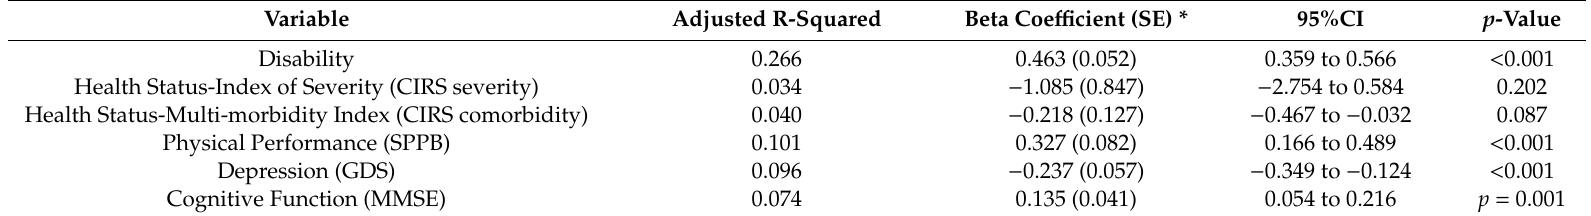
Table 2. Association between each factor and reduced M-MNA total score ( ≤